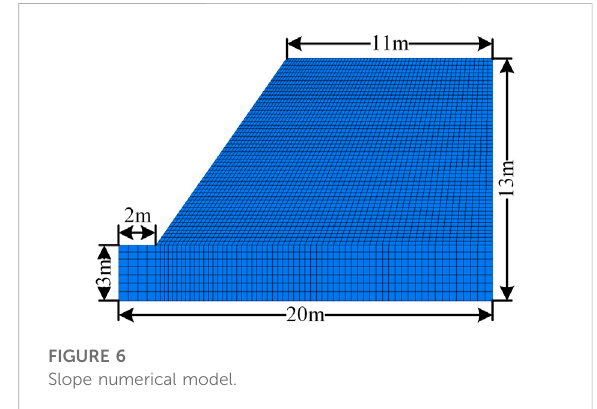
FIGURE 6 Slope numerical